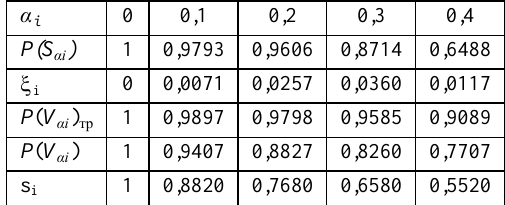
Fig. 5 . Profilogram and diagram of filling the rough layer with a material along the 100-200 section of the profilogram depicted on fig. 2. Table 2. Results of probabilistic parameters calculation along the length 100-200 mm of the profilogram.